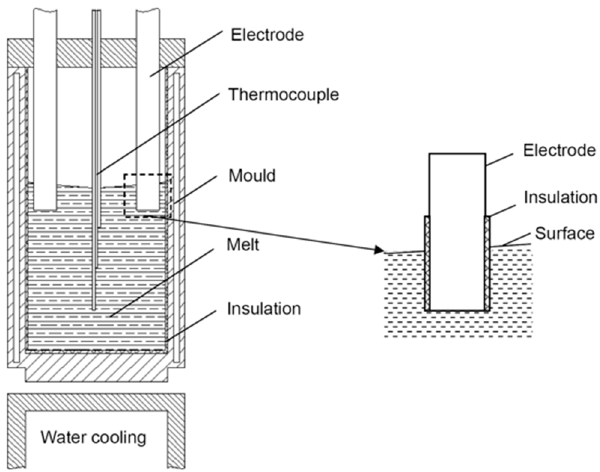
Figure 1. Schematic drawing of the experimental setup.